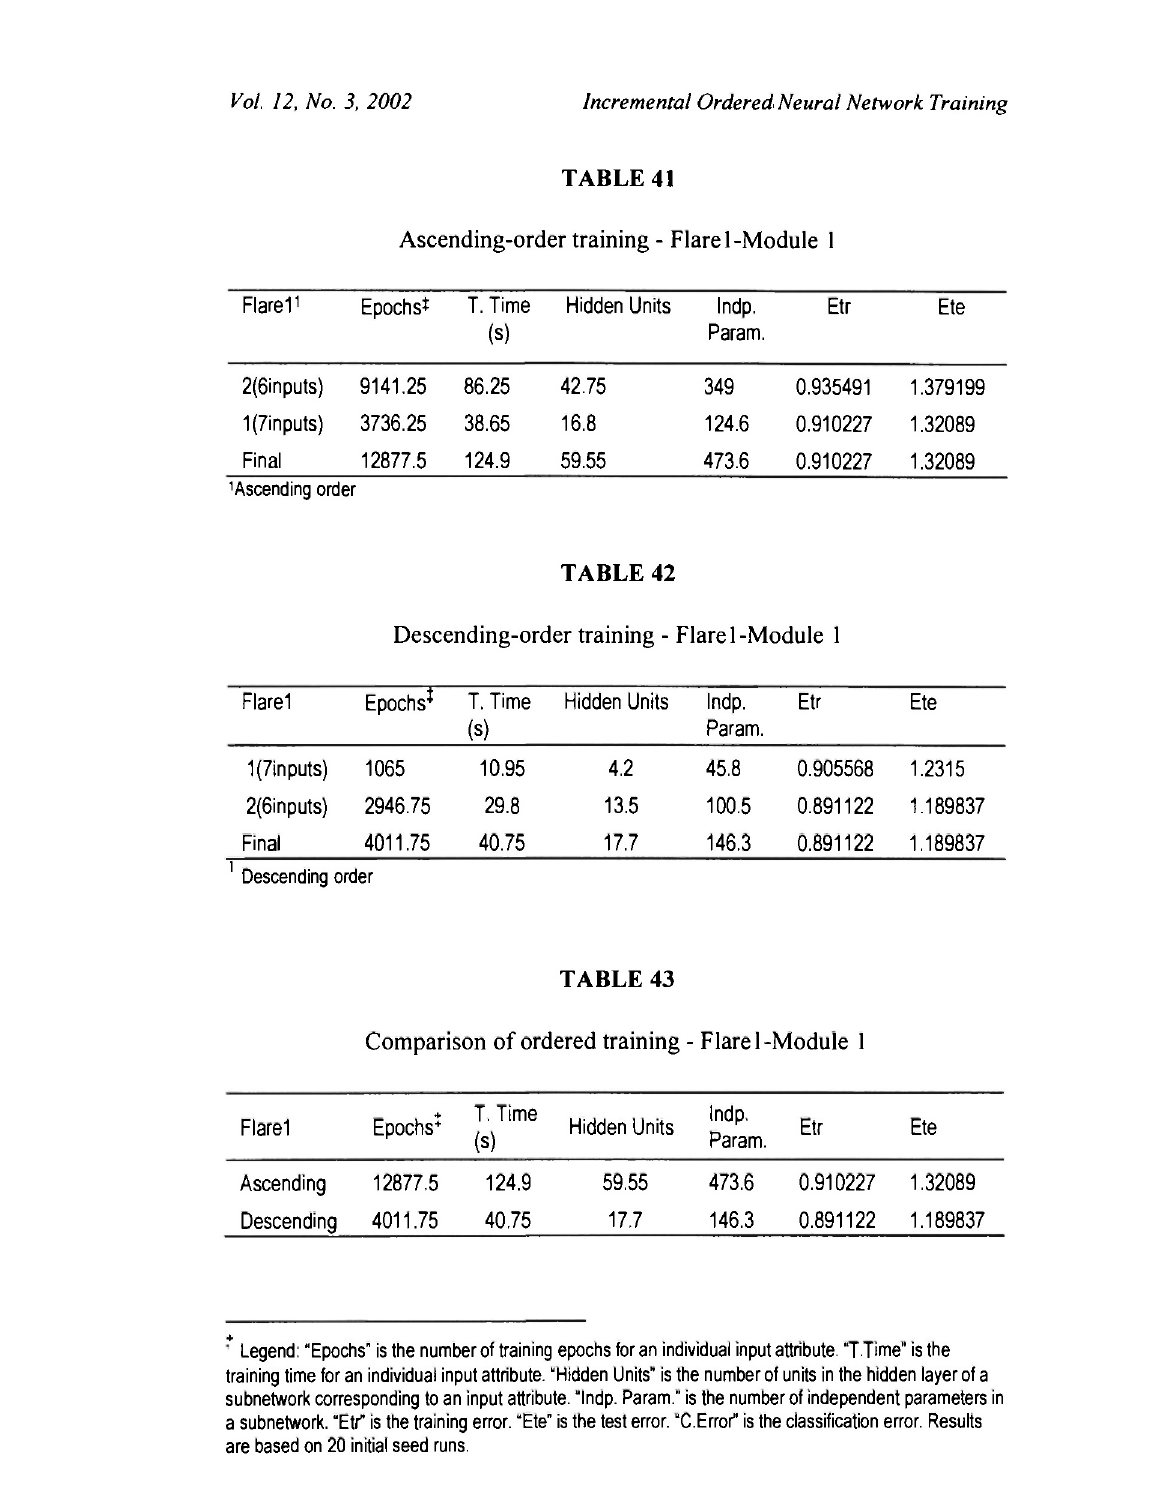
Ascending-order training - Flare 1 -Module 1